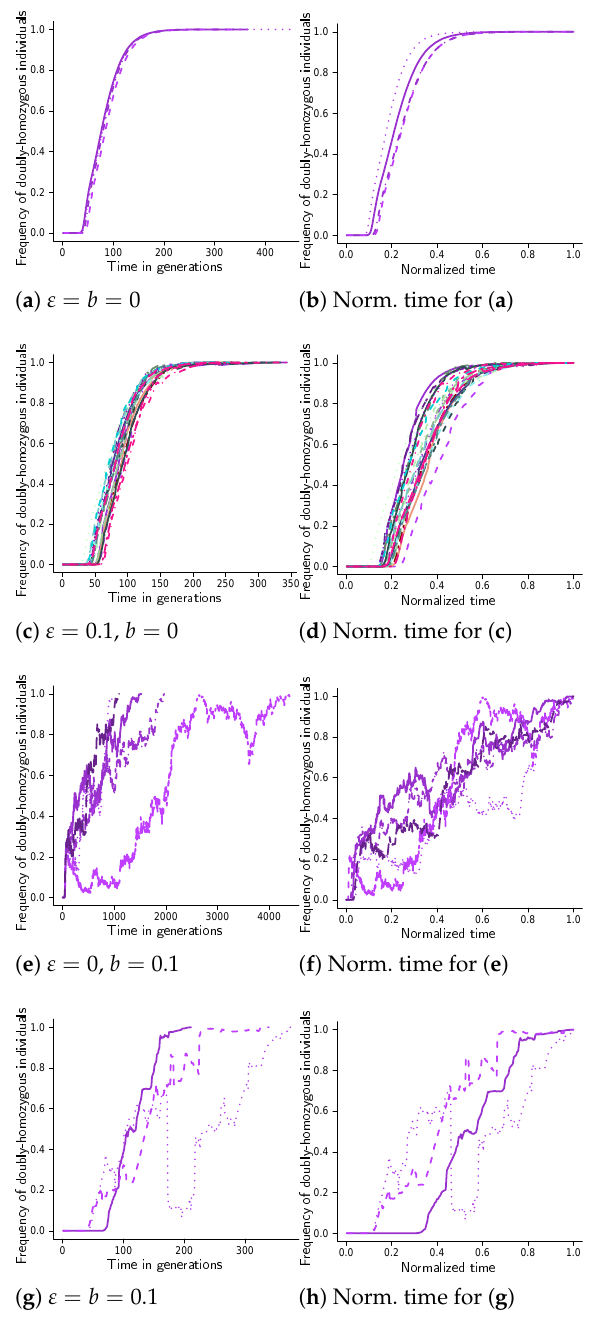
Figure A1. Two sites with weight function as in Equation (A1). Examples of trajectories to fixation at two sites with weight determined by Equation (8) with weight function as in Equation (A1) for carrying capacity C = 10 6 , cutoff u ( N ) = C , probability of recombination r = 0.25 between adjacent sites, α 1 = 0.75, α 2 = 3, ε (see Equation (7)) and probability of a bottleneck b as shown, strength of selection s = 0.1 and bottleneck B = 10 3 . Each panel shows the trajectories from ten experiments for ( a , b ) otherwise from 10 2 experiments. Each trajectory traces, as a function of time, the number of diploid individuals homozygous for the fit type at all sites relative to the population size (the number of diploid individuals). The panels on the right ( b , d , f , h ) show the corresponding excursions from the left panels ( a , c , e , g ), where the time to fixation for each excursion is normalized by the time to fixation for the excursion. The scale of the abscissa (time axis) may vary between panels; in each panel the trajectories were all obtained under identical